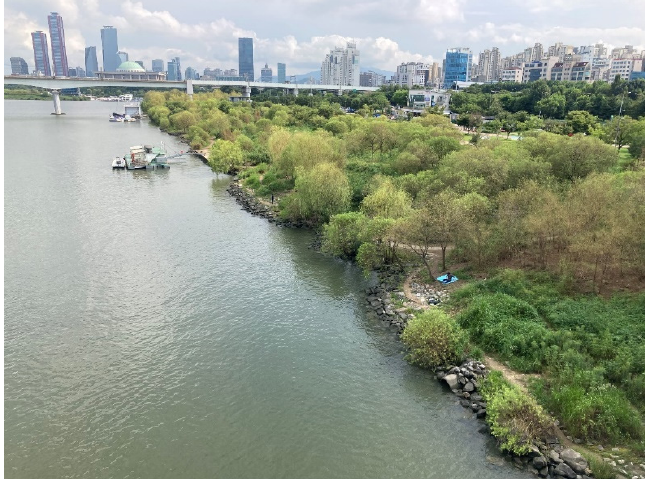
Figure 8. Bird eye’s view of mud infrastructure (source: author’s photograph).